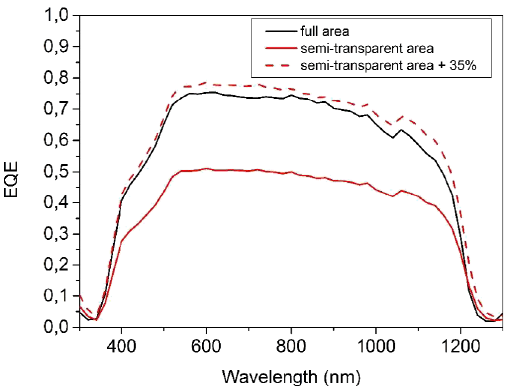
Fig. 6. EQE curves in full (black) and semi-transparent (red) areas